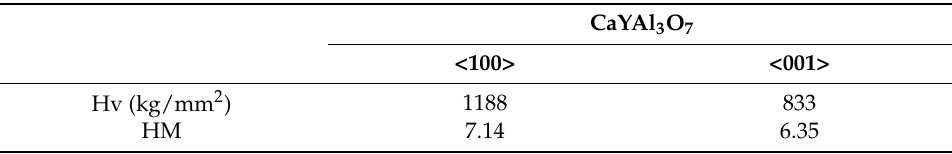
Table 2. Microhardness (Hv) hardness and Mohs hardness.